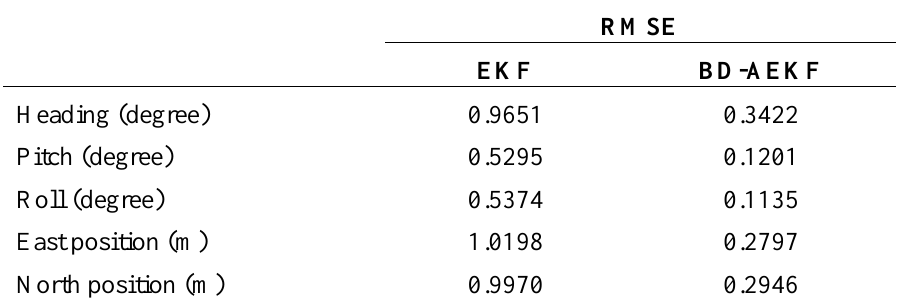
Table 12. Comparison of errors between EKF and BD-AEKF